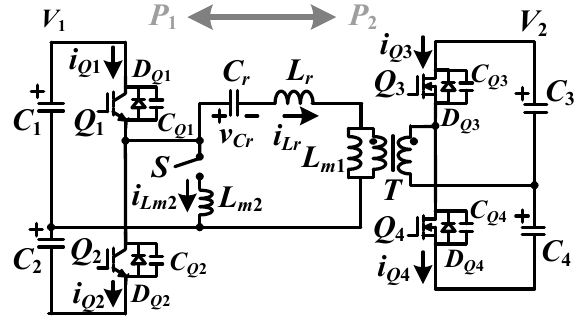
Figure 1. Circuit schematic of the proposed dual half-bridge converter.